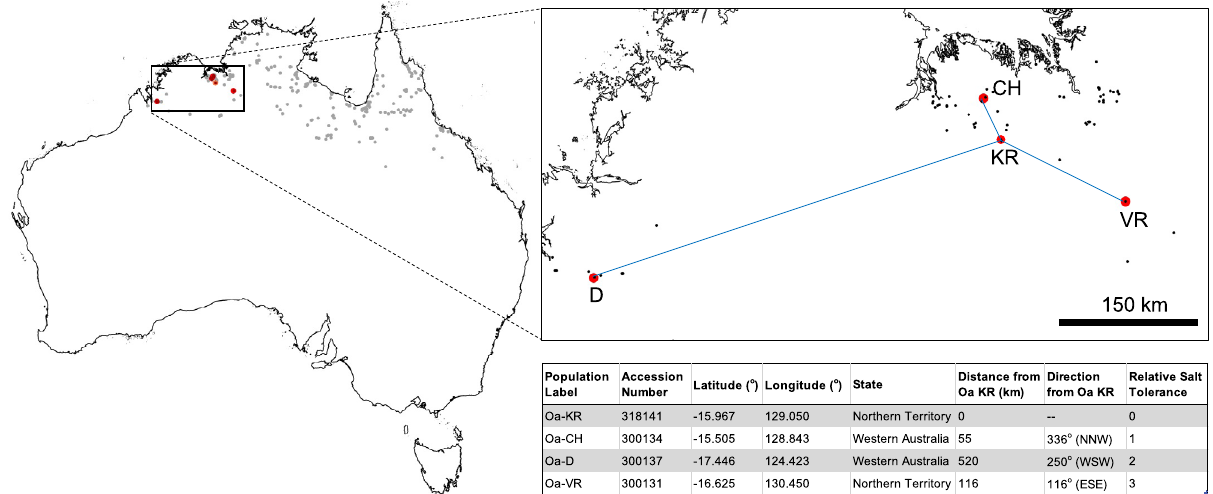
Figure 1. Locations of O. australiensis seed collection sites for this study. List of wild rice accessions (obtained from the Australian Grain Genebank) used in this study reported by Yichie et al. 19 to demonstrate varying degrees of salt tolerance. Dots on the map show the occurrence of O. australiensis (retrieved from the Atlas of Living Australia). In-set table: accessions are ordered by salt tolerance, with Oa-KR being the most sensitive to salt, and Oa-VR being most tolerant 19